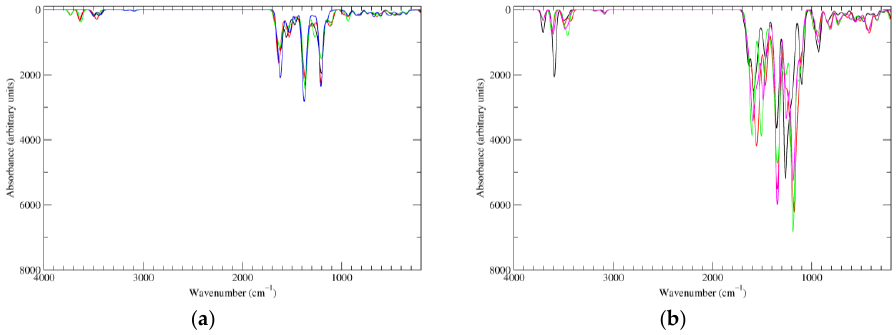
Figure 8. Computed IR spectra of the most significant tautomers/conformers in the four-electrons oxidation state. ( a ) Neutral form in vacuo: black line, a16_b6_c6_d0, C 1 , conf1; red line, a6_b16_c6_d0, C 1 , conf1; green line, a6_b6_c16_d0, C 1 , conf1; blue line, a6_b6_c6_d6, C 2 , conf1. ( b ) Neutral form in